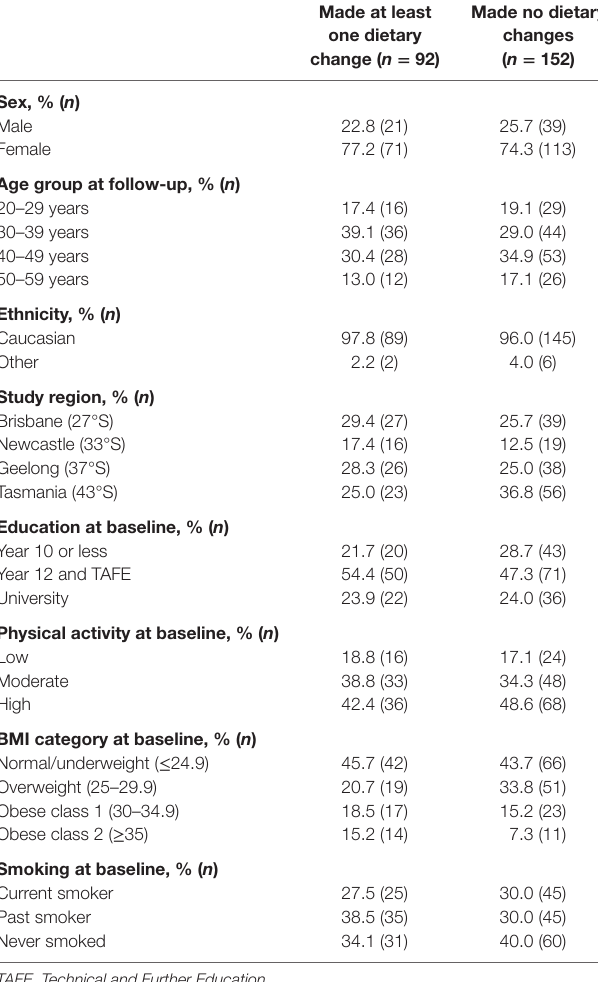
TaBle 1 | Characteristics of participants ( n = 244) in the 1-year follow-up of the Ausimmune Study according to whether or not they made at least one dietary change in the year after a first clinical diagnosis of CNS demyelination. Made at least one dietary